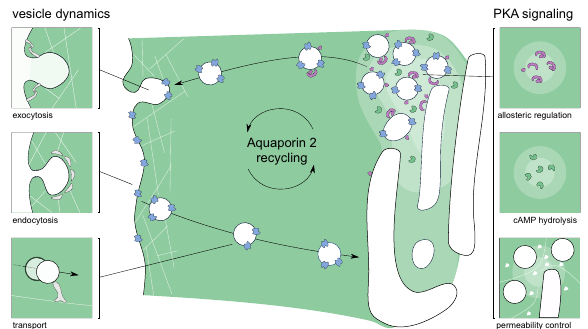
Fig. 1 Overview of key mechanisms involved in Aquaporin 2 recycling. Macroscopic phenomena are displayed on the left side of the fi gure, whereas microscopic phenomena are displayed on the right. AQP2-positive vesicles are transported from the intracellular storage region to the apical membrane upon cAMP